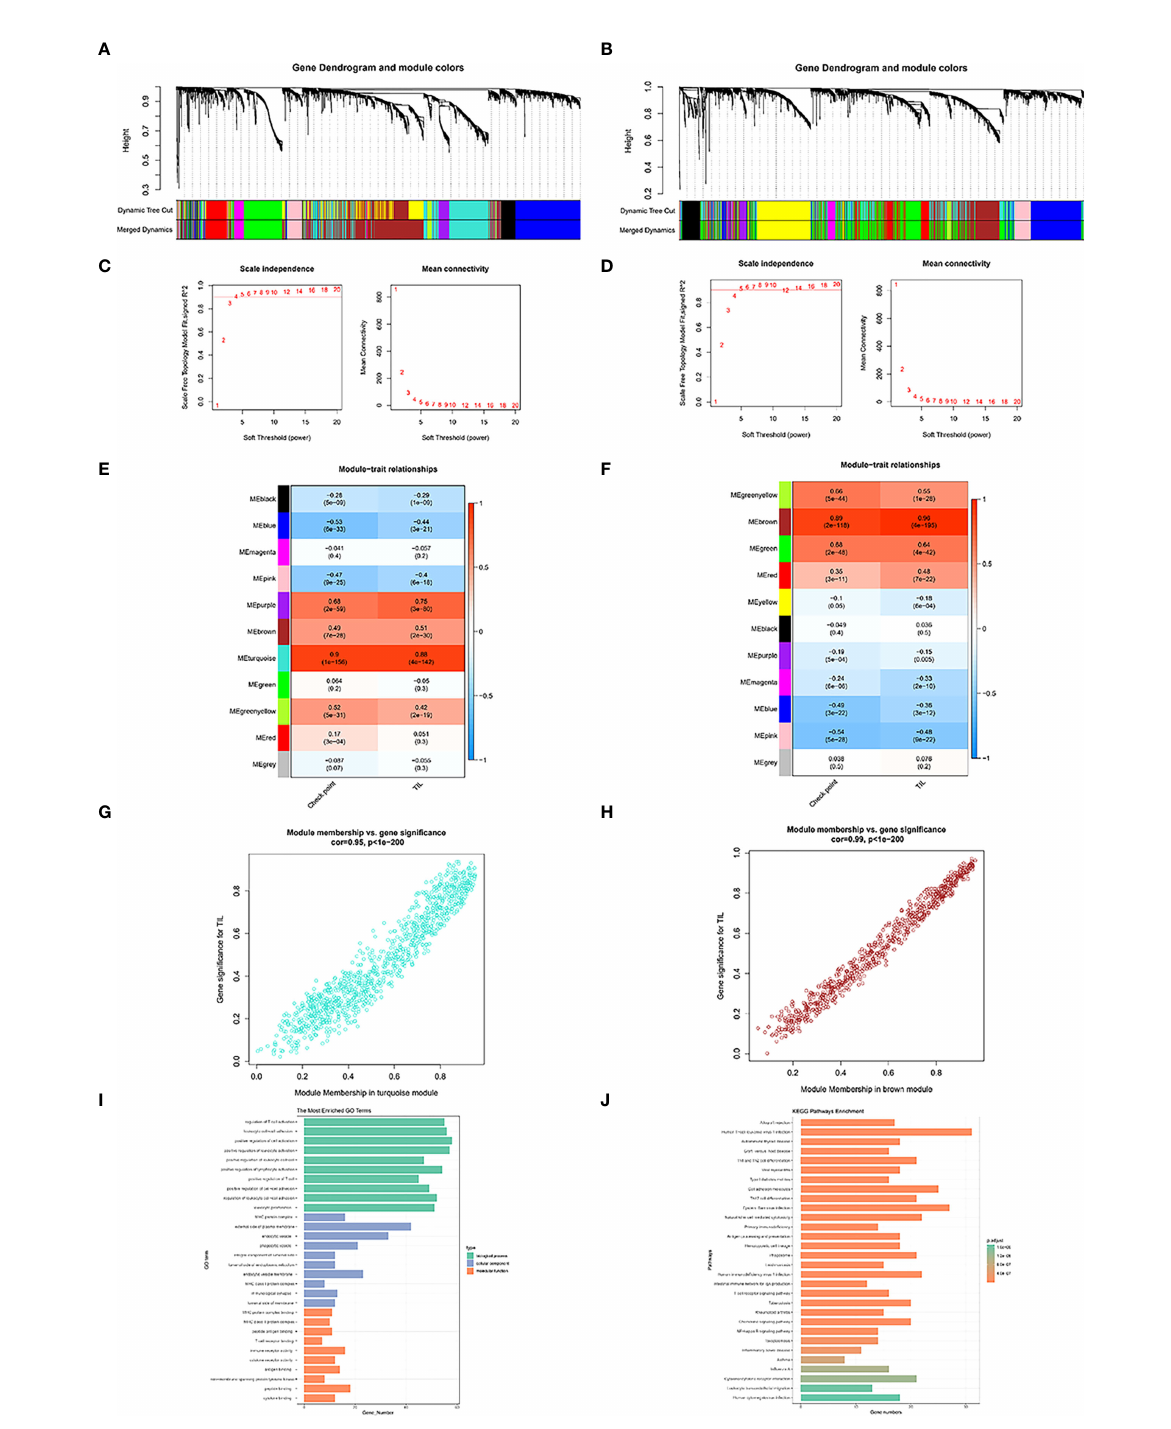
FIGURE 1 Co-expression network generated using WGCNA. Dendrogram of robust TIL clustered based on a dissimilarity measure (1-TOM) of TCGA-BLCA (A) and IMvigor210 dataset (B) . Analysis of network topology for various soft-thresholding powers of TCGA-BLCA (C) and IMvigor210 dataset (D) .Heatmap demonstrating the correlation between module eigengenes and TIL in the TCGA-BLCA (E) and IMvigor210 dataset (F) . The correlations between TCGA turquoise module membership and TIL-related genes (TILRGs) signi fi cance (G) . The correlation between IMvigor210 brown module membership and TILS (H) . Gene ontology (GO) (I) and Kyoto Encyclopedia of Genes and Genomes (KEGG) (J) analyses of TIL- related intersecting